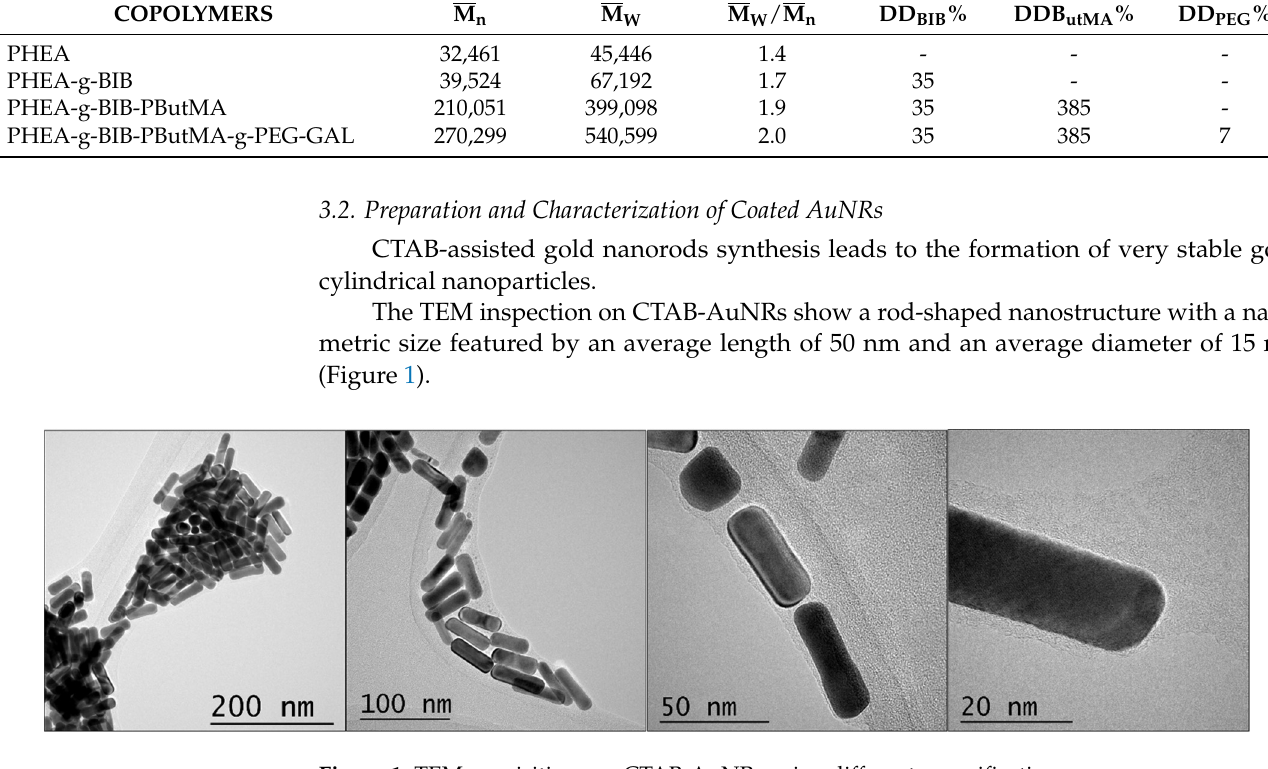
Figure 1. TEM acquisitions on CTAB-AuNRs using different magnifications.